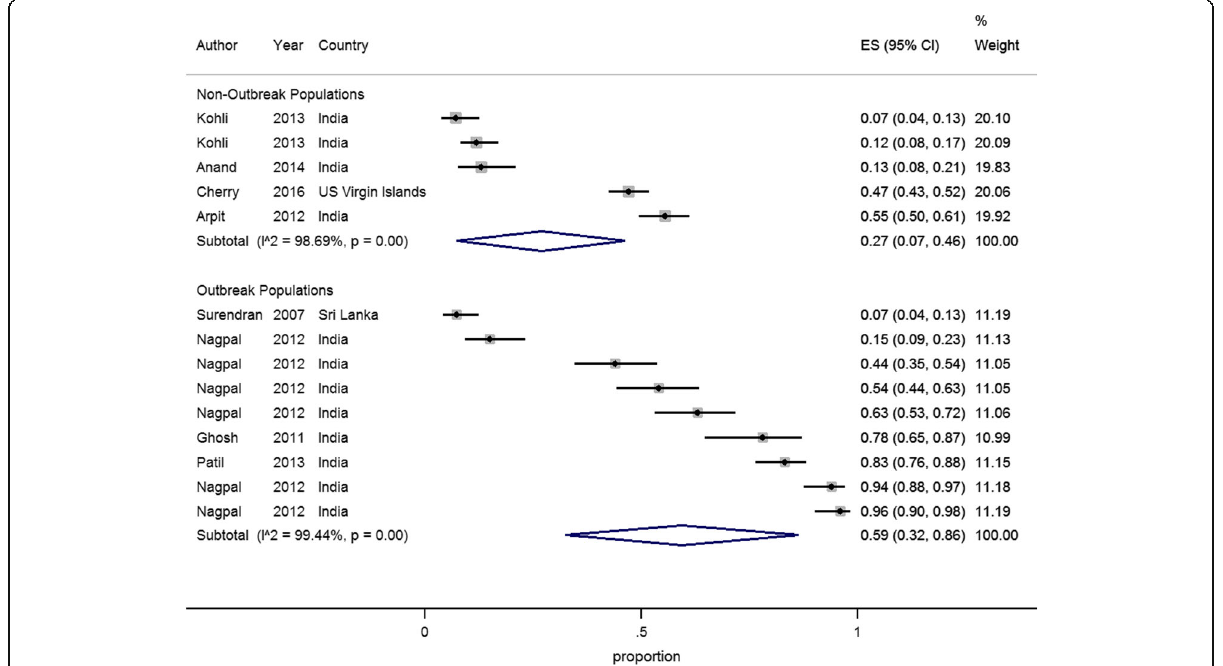
Fig. 2 Meta-analysis of the proportion (ES, 95% CI) of the general public sample population that were aware of chikungunya in outbreak and non-outbreak